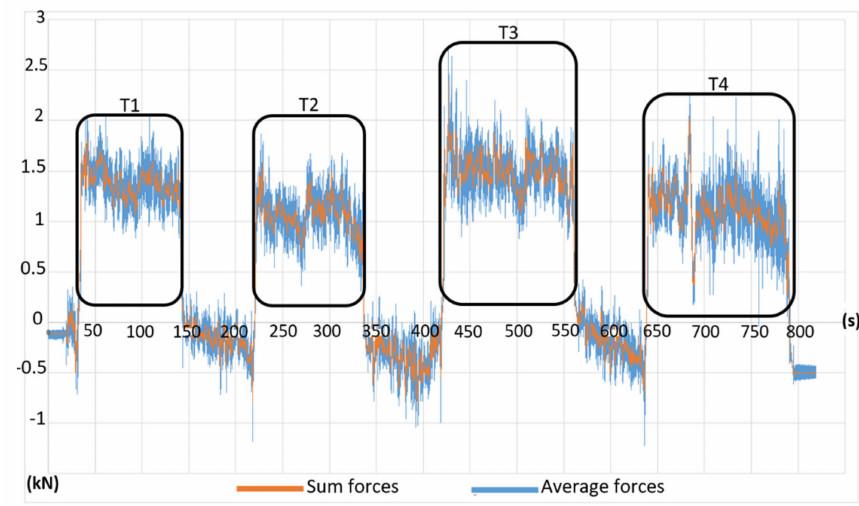
Figure 8. Plotted average of horizontal force (kN) during the weeding operation. Vertical axis represents the forces (kN) and horizontal axis shows the time (s). Table 7. The results of the calculation of required energy for the weeding